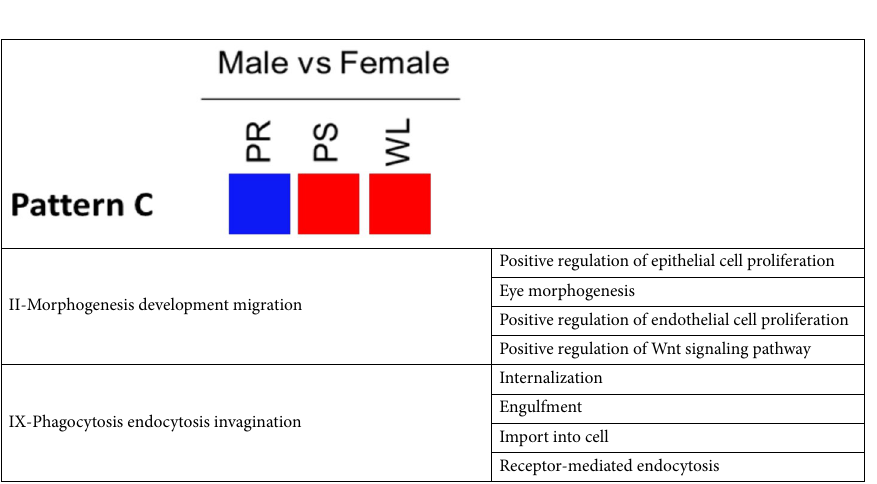
Table 8. Summary of clusters and gene sets included in the pattern C for the renal IRI sex